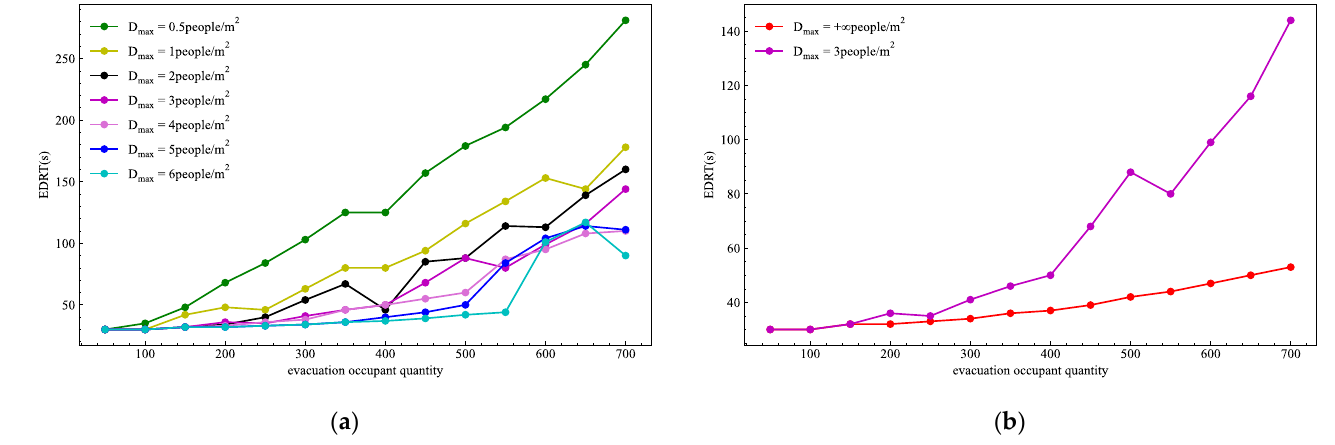
D between EDRT and the number of Figure 14. The relationship corresponding to different max Figure 14. The relationship corresponding to different D max between EDRT and the number of D on EDRT; ( b ) The polyline is evacuees. ( a ) The polyline is about the influence of different evacuees. ( a ) The polyline is about the influence of different D max on EDRT; ( b ) The polyline is about max 3people / m = D and no path capacity constraints on EDRT. about the influence of 2 the influence of D max = 3people/m 2 and no path capacity constraints on max